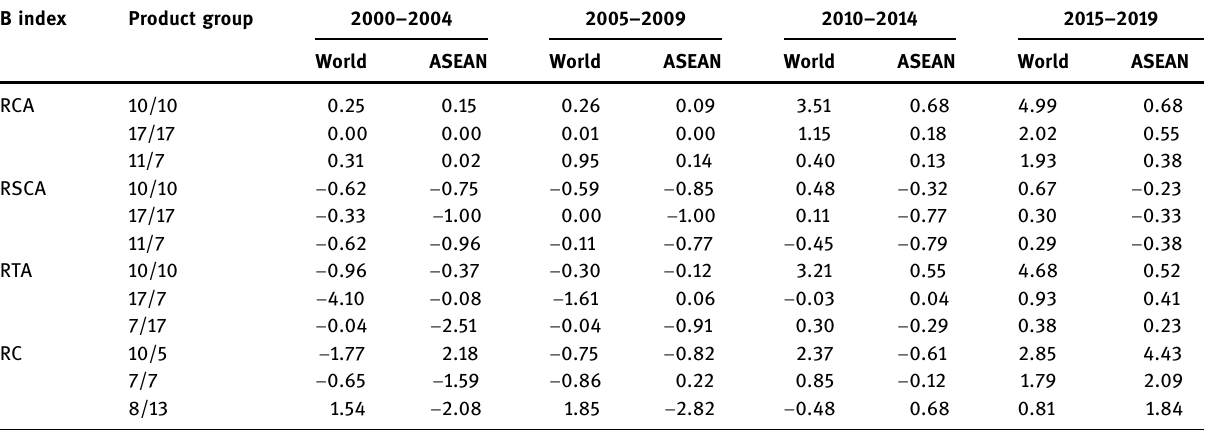
Table 5: The three highest Balassa indices of Cambodia at World and ASEAN level, 2000 –